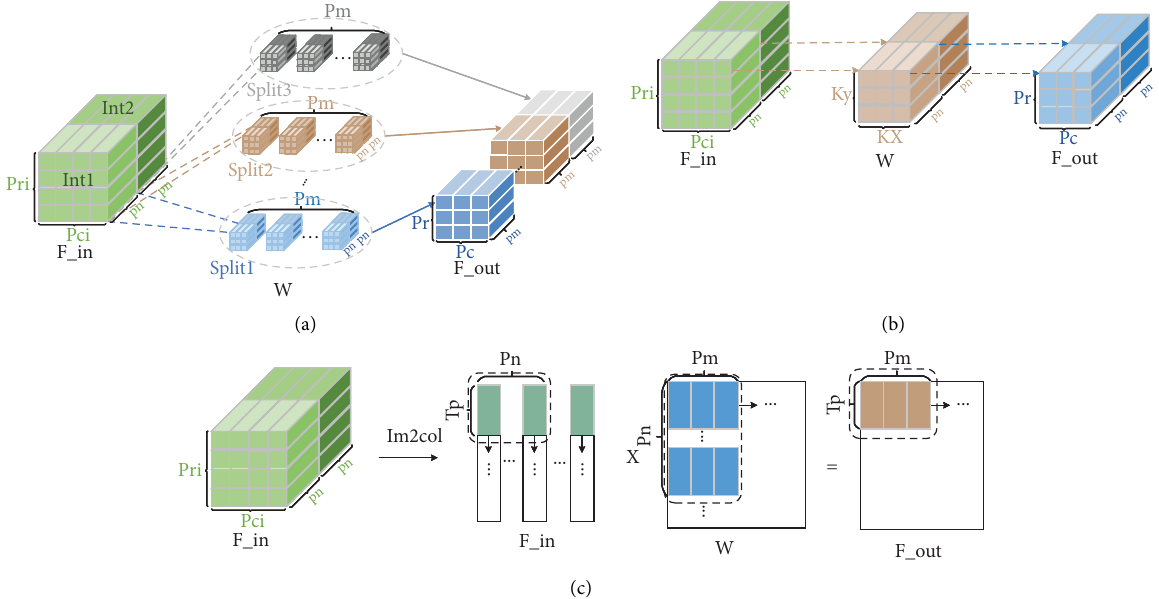
Figure 3: Block convolution strategy. (a) Standard convolution. (b) Depth-wise convolution. (c) Point-wise convolution. P the width, height, and channel of the input block feature map. P r , P c , P m , and P n are the width and height of the output block feature map, the number of convolution kernels, and channels, respectively.